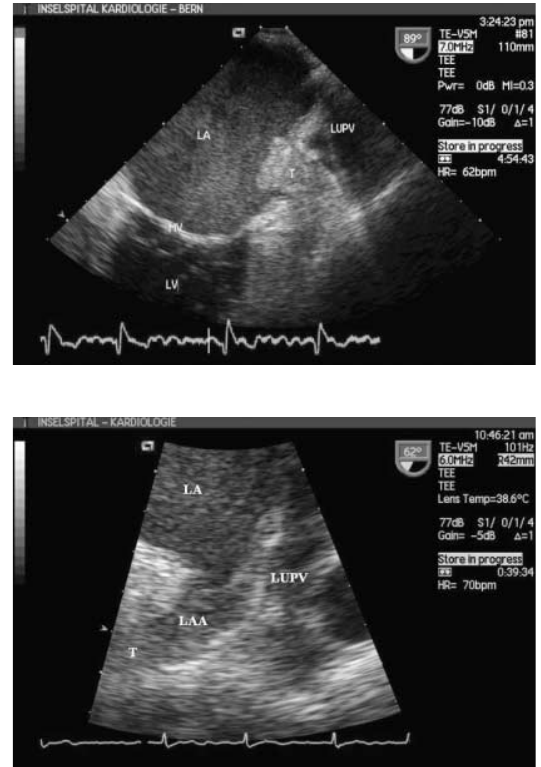
Transoesophageal echocardiography after 1